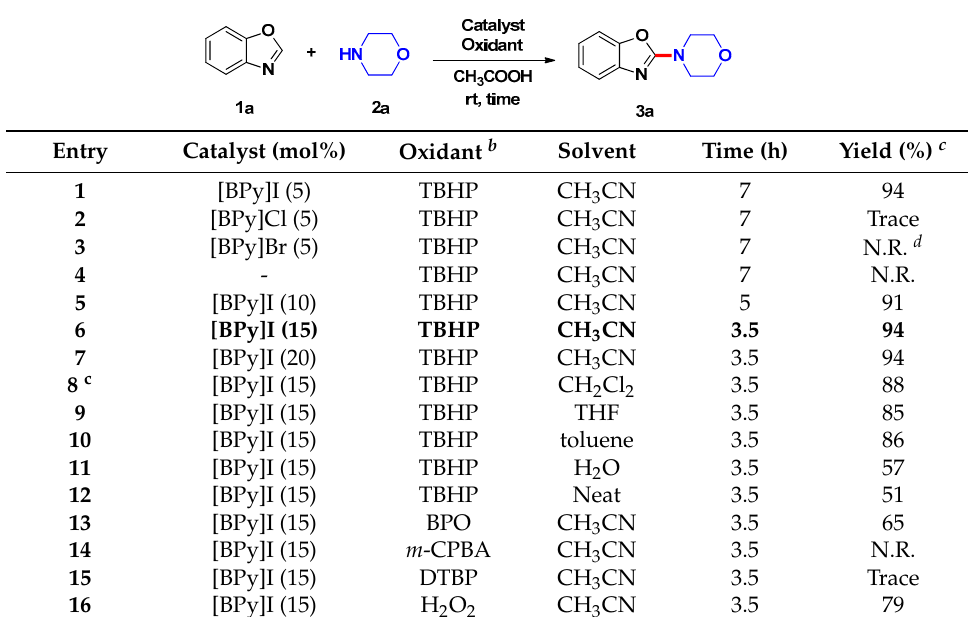
Table 1. Optimizing the reaction conditions. a